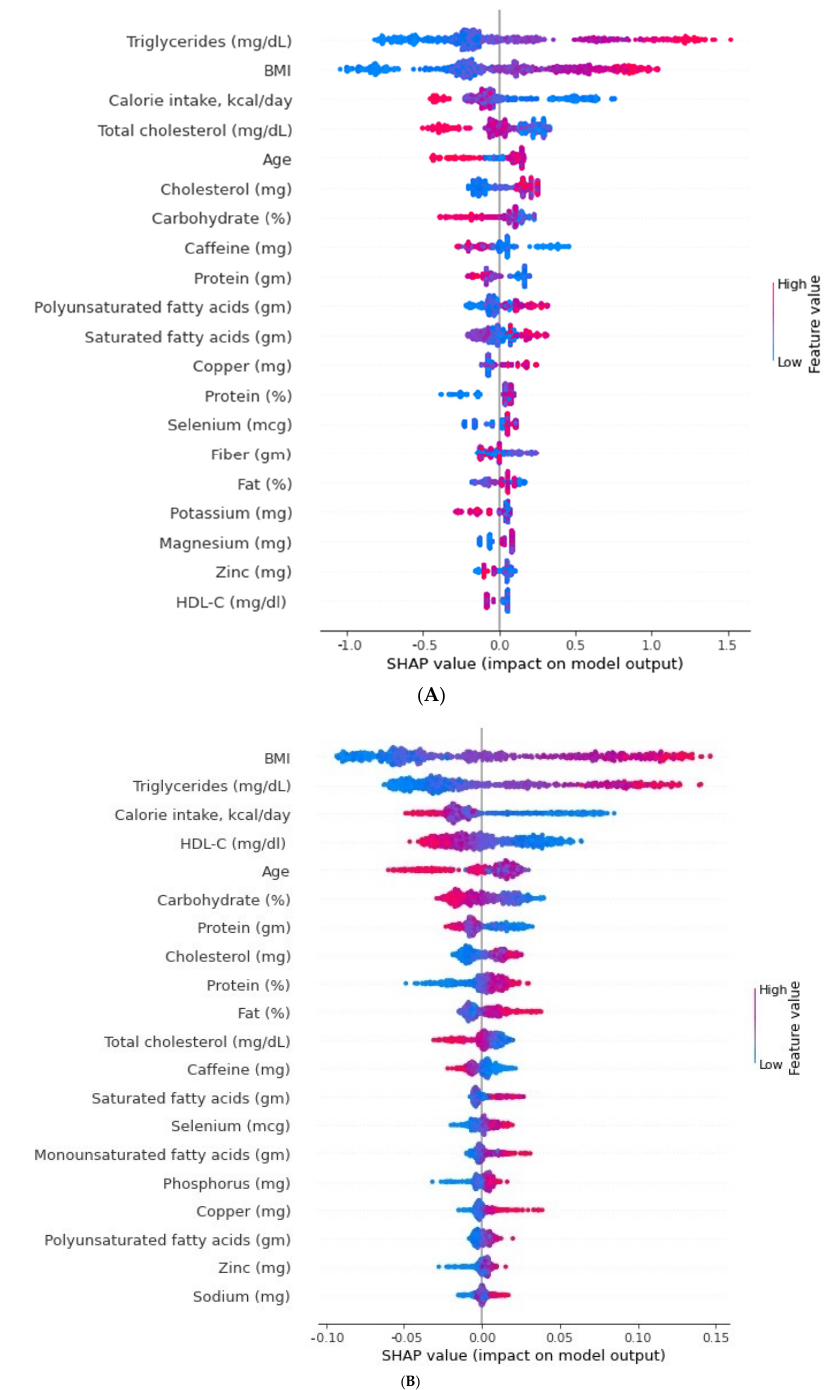
Figure 4. Positive and negative impact explanation of features for predicting insulin resistance using SHAP values. ( A ) for XGBoost and ( B ) for RF. Well separated to show a positive or negative association with IR in terms of SHAP value for the XGBoost algorithm ( A ), including blood triglyceride value (strongly positive impact), BMI (strongly positive impact), daily calorie intake (medium negative impact), and blood total cholesterol value (medium negative impact). For the RF algorithm ( B ), almost all features were well separated to show a positive or negative association with IR in terms of SHAP value. ( A ) Explanation of each feature impact on the IR in the prediction model using the SHAP values in the XGBoost algorithm. ( B ) Explanation of each feature impact on the IR in the prediction model using the SHAP values in the RF algorithm.